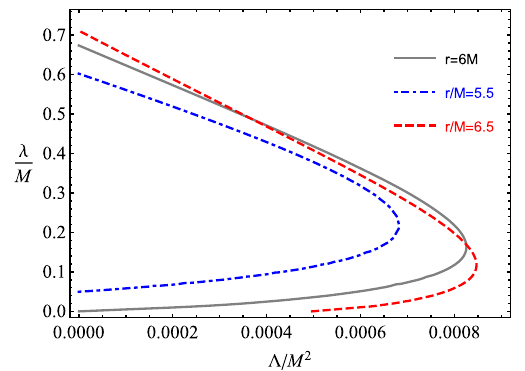
Fig. 4 The dependence of the cosmological constant Λ on the perfect fluid dark matter parameter λ for a test particle on circular orbit for which the ISCO radius is the same as the ISCO in the Schwarzschild